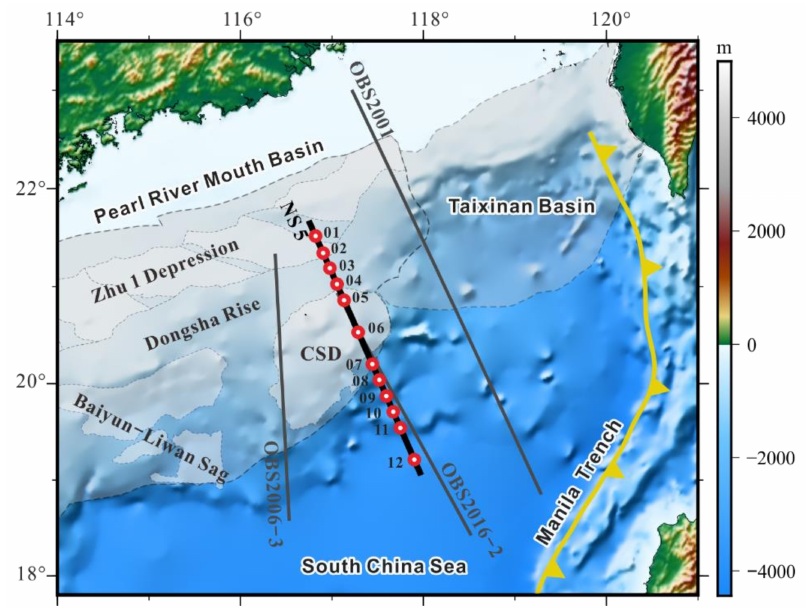
Figure 1. Topography and bathymetry map of north-eastern South China Sea (SCS) with the location of deep seismic survey lines. The gray lines represent the deep seismic survey lines which have conducted the studies of converted S-waves, including OBS2001 [4], OBS2006-3 [13], OBS2016-2 [14]. The thick, black, solid line is the profile NS5 in this study. Red dots repre- sent ocean bottom seismometers (OBSs). Gray areas represent the distribution of the Pearl River Mouth Basin and Taixinan Basin. The yellow curve with triangles denotes Manila Trench. CSD: Chaoshan